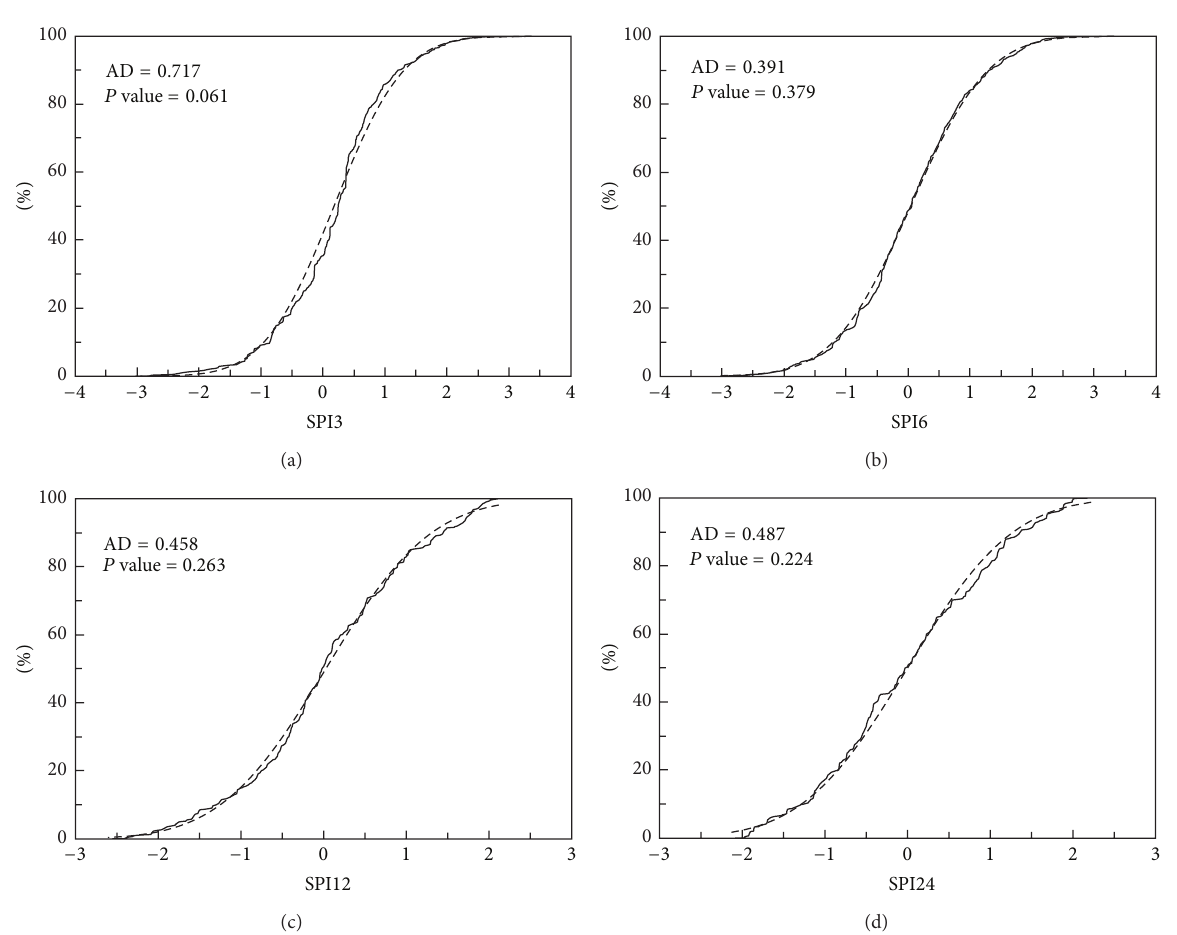
Figure 3: Standardized Precipitation Index (SPI) for the rainfall data plotted as probability distribution functions for the time scales of 3, 6, 12, and 24 months. The dashed curve represents the theoretical cumulative distribution, and the solid curve is the fitted empirical cumulative distribution. AD corresponds to Anderson-Darling